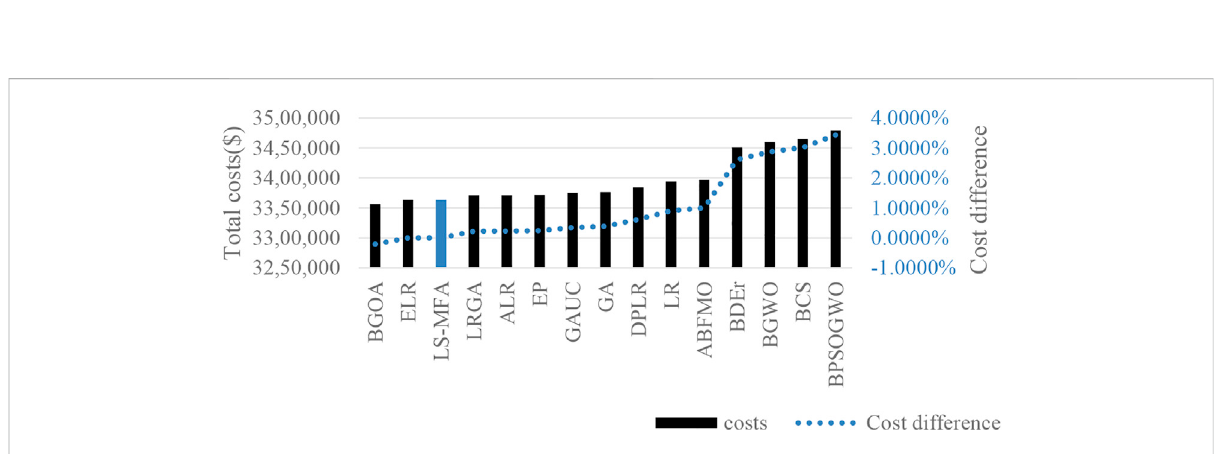
FIGURE 11 Comparison of total cost with reported optimization techniques for 60-unit